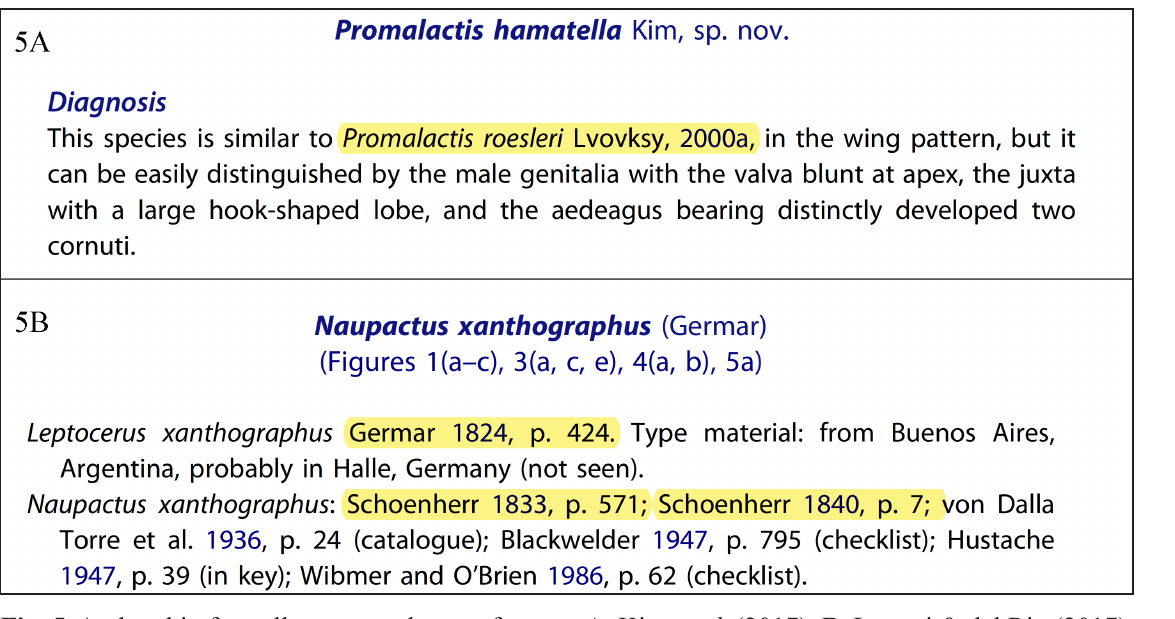
Fig. 5. Authorship formally presented as a reference. A . Kim et al. (2017). B . Lanteri & del